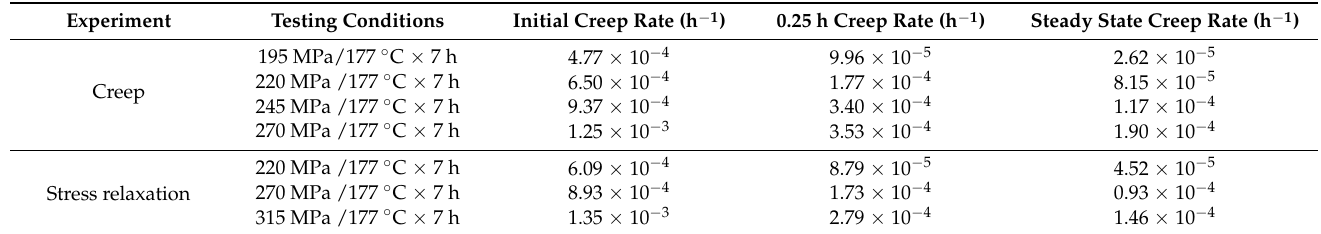
Table 2. Creep strain rate of single-stage creep/stress